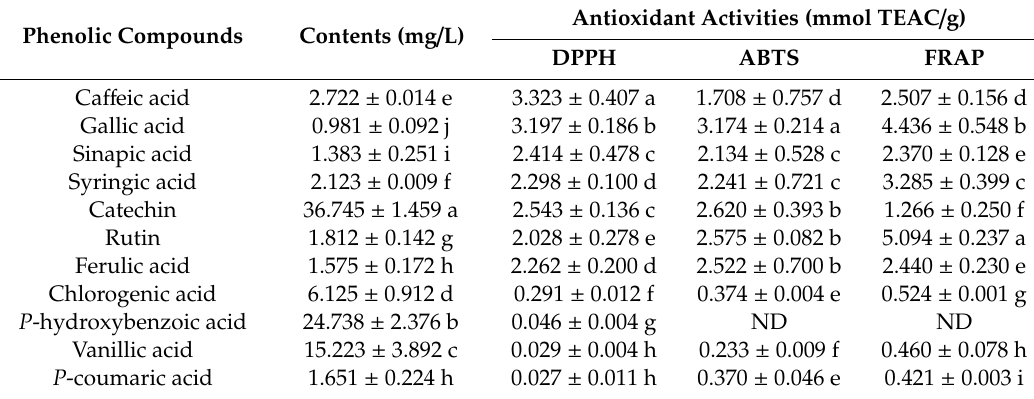
Table 4. Phenolic compounds contents and antioxidant activities in ZAV-5 1,2,3 .